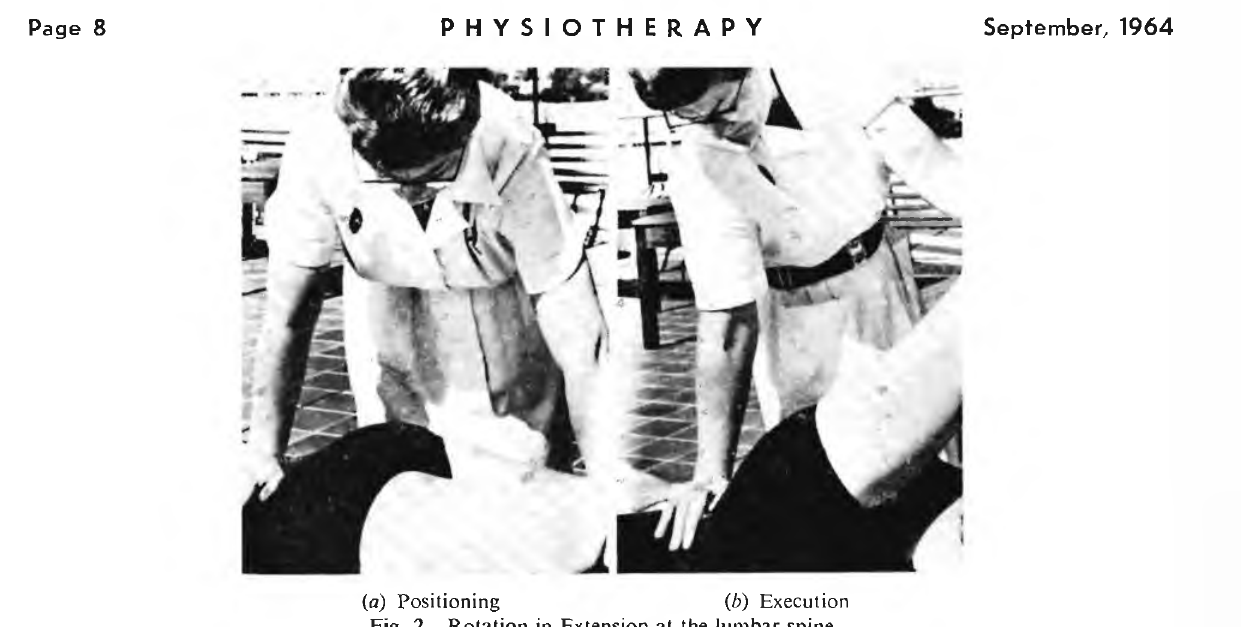
(a) Positioning (b) Execution Fig. 2 Rotation in Extension at the lumbar